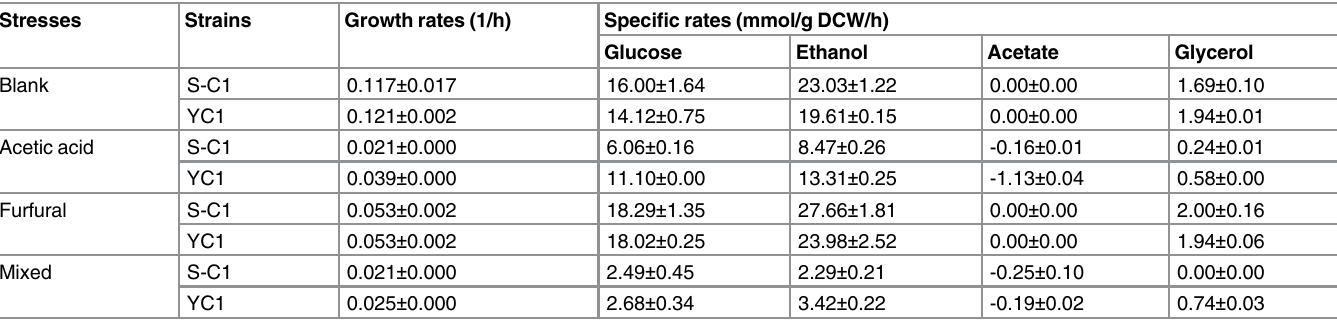
Table 2. Growth of S-C1 strain and YC1 strain under different stress